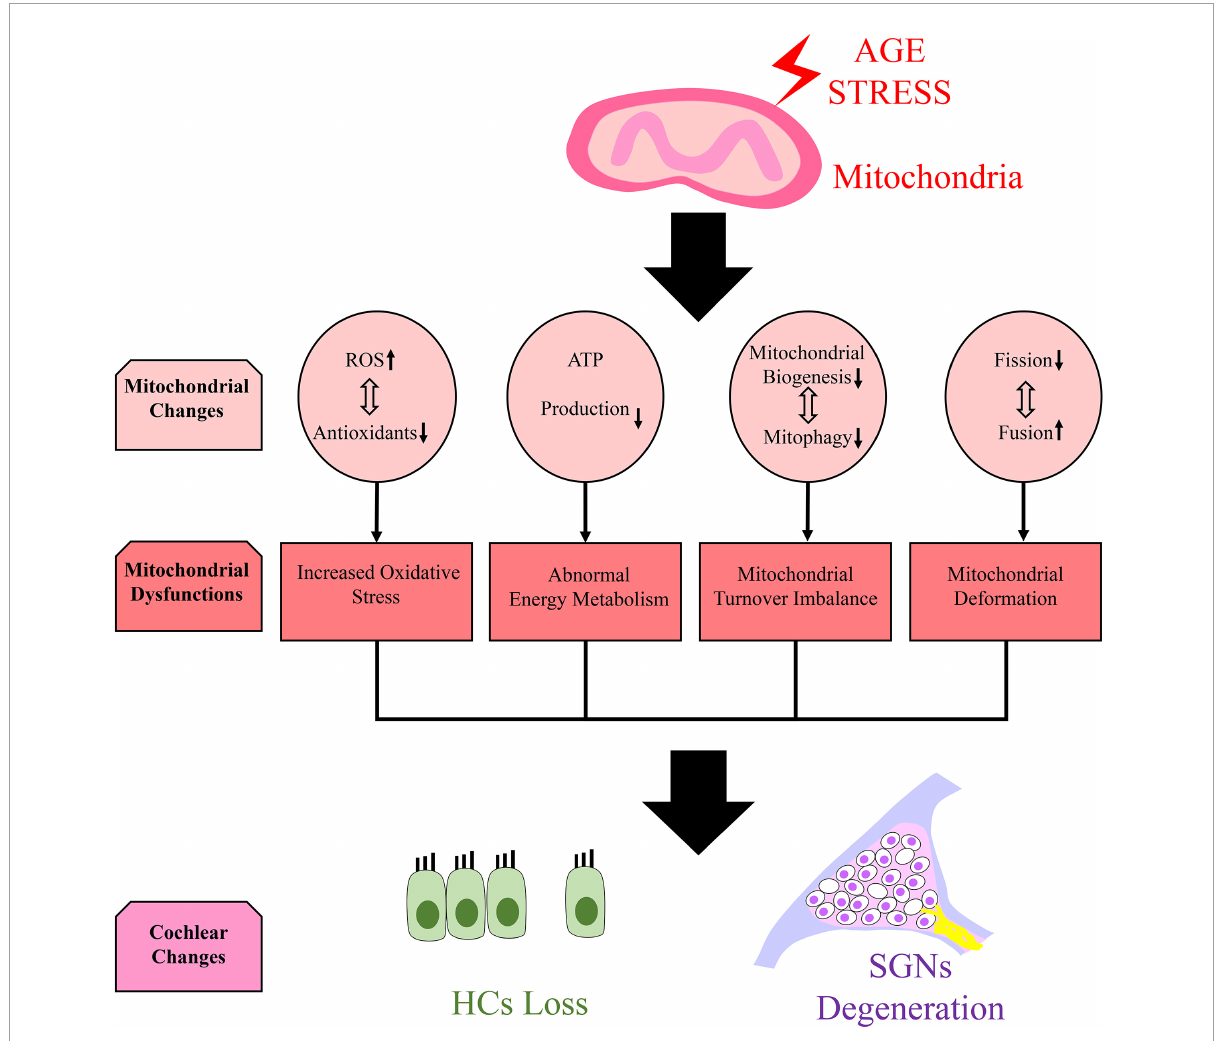
FIGURE1 Mitochondrial dysfunction and cochlear changes caused by age stress. We speculate that mitochondrial dysfunction which manifests as increased oxidative stress (Chen et al., 2017), abnormal energy metabolism (Guo et al., 2020), imbalance mitochondrial turnover (Oh et al., 2020) and mitochondrial deformation (Lin et al., 2019) can be found in cochlea due to several mitochondrial changes caused by age stress. It can lead to hair cells (HCs) loss and spiral ganglion neurons (SGNs) degeneration in